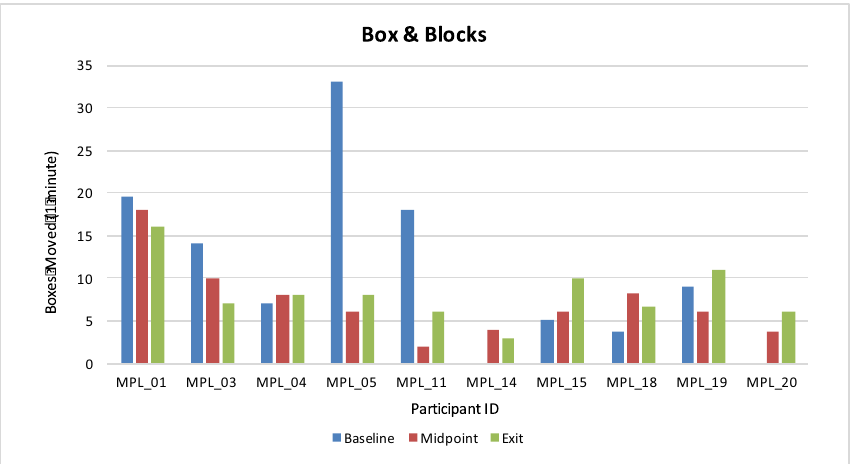
Figure 2. Number of boxes moved during the Box and Blocks assessment for each participant during the baseline, midpoint, and exit sessions. The Box & Blocks task was performed in triplicate during each session and the number of blocks moved was averaged. Two participants (MPL_14 and MPL_20) did not have or regularly use a conventional prosthesis at the time of study participation and did not perform the Box & Blocks task as part of a baseline